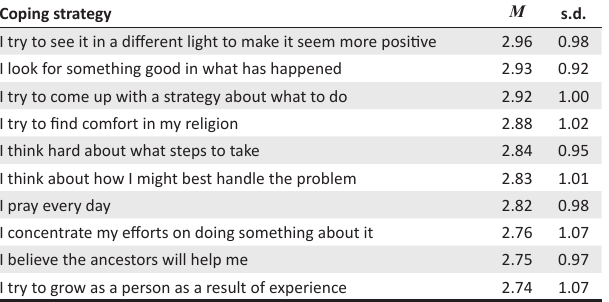
TABLE 7: The most frequently used coping strategies. Coping strategy M